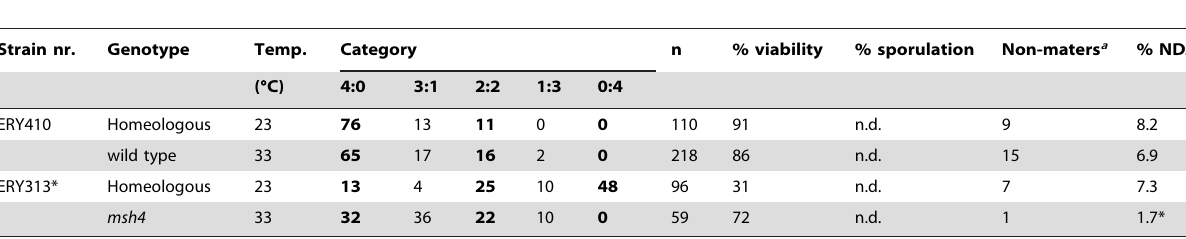
Table 4. Gamete viability of strains carrying a homeologous chromosome pair.